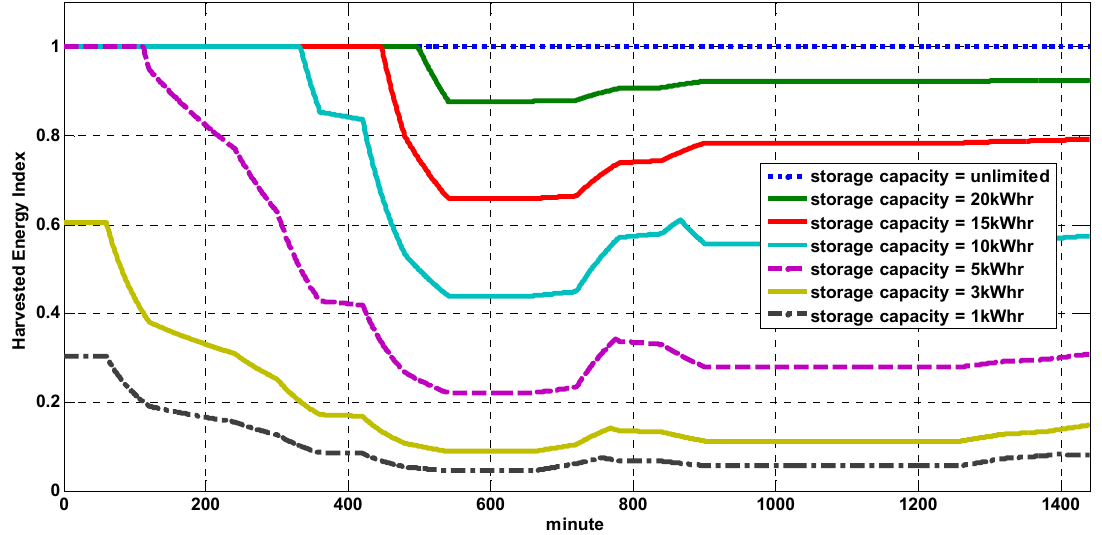
Figure 8. Harvested Energy index for different energy storage